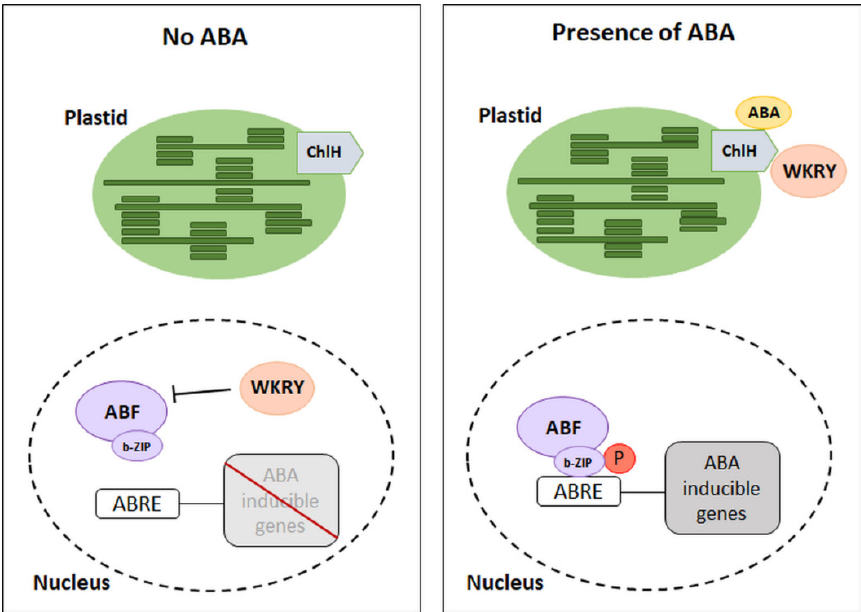
Figure 3. Mechanism of ABA-dependent gene inhibition by WKRY. ChlH: ABA receptors, WKRY: transcription factors (negative regulators of transcription), ABRE: ABA-responsive element, ABF: ABRE binding factor with b-ZIP—leucine zipper domain, P: phosphorylation. (Modified from [14,24]).